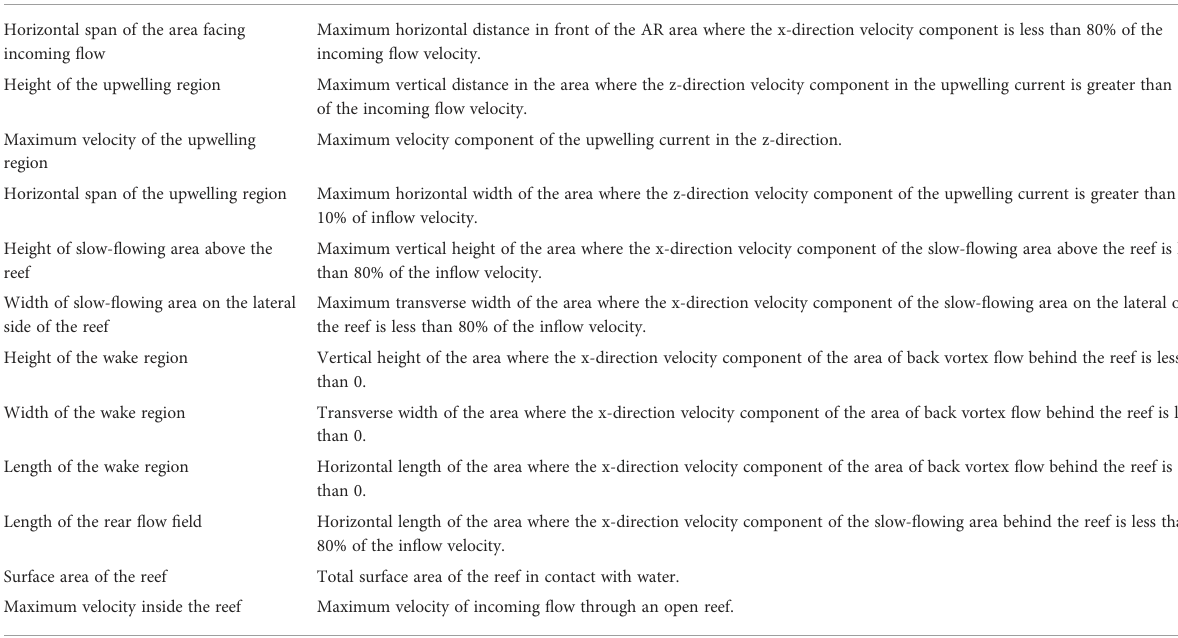
TABLE 3 Evaluation indices and de fi nitions of the fl ow fi eld effect of ARs. Evaluation